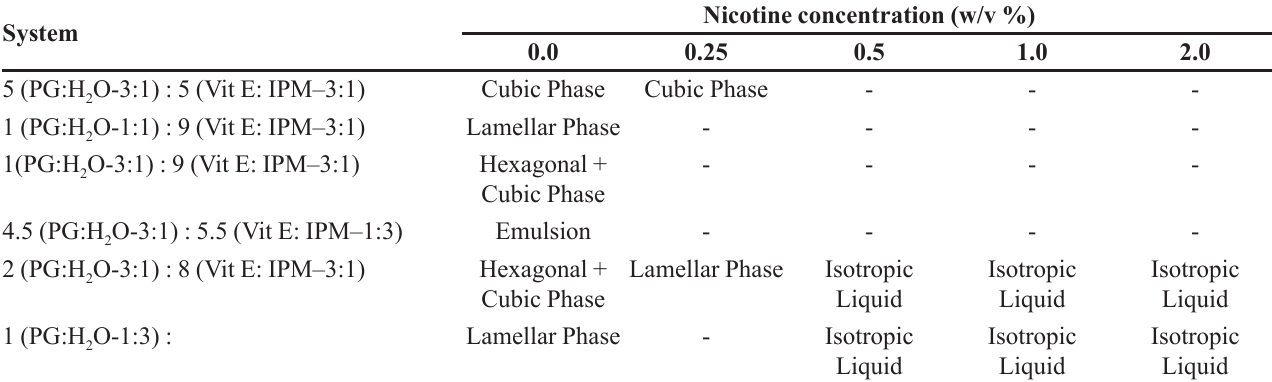
FIGURE 3 - Photomicrographs by polarized light microscopy. (A) Hexagonal phase composed of Vitamin E TPGS/IPM/PG-H (3:1) at 67.5:22.5:7.5:2.5 w/w/w/w; (B) Unstable emulsion composed of Vitamin E TPGS/IPM/PG-H w/w/w/w, (C) Lamellar phase composed of Vitamin E TPGS/IPM/PG-H2O (1:1) at 60:20:10:10 w/w/w/w and (D) Cubic phase (cubic phase+water) composed of Vitamin E TPGS/IPM/PG-H2O (1:3) at 22.5:67.5:2.5:7.5 w/w/w/w. Increase 200X. TABLE I - Structural identification by visual analyses and polarized light microscopy of different formulations